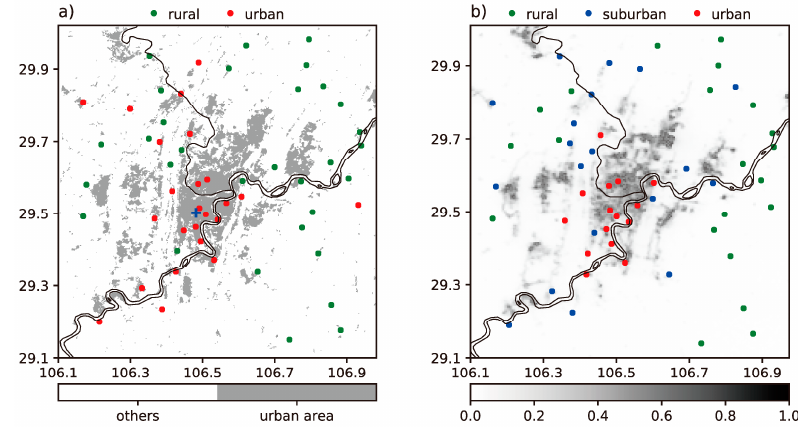
Figure 2. ( a ) Locations of urban (red dots) and rural (green dots) sites classified by 30-m land use (gray patches) from Institute of Geographic Sciences and Natural Resources Research in Chinese Academy of Sciences. Blue cross indicates the location of Shapingba sounding station. ( b ) Locations of urban (red dots), suburban (blue dots), and rural (green dots) sites sorted by normalized nighttime light index (NNLI) from the Visible Infrared Imaging Radiometer Suite day/night band (VIIRS-DNB) (shades; see the text).